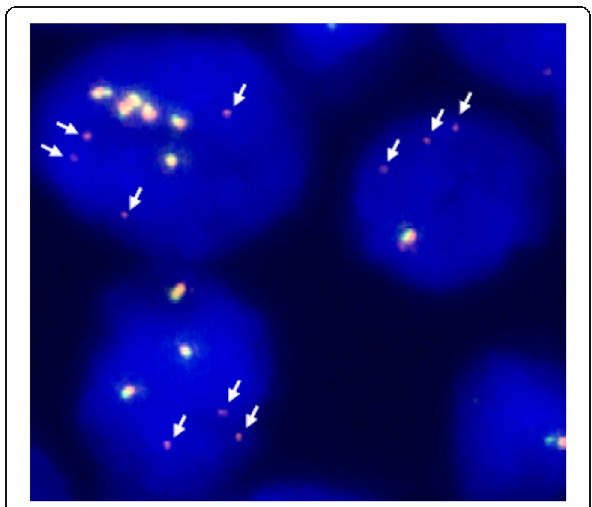
Fig. 3 NTRK3 break apart FISH (original magnification 1000x): Tumour cells show fusion signals and additional faint single orange signals (marked by arrows)